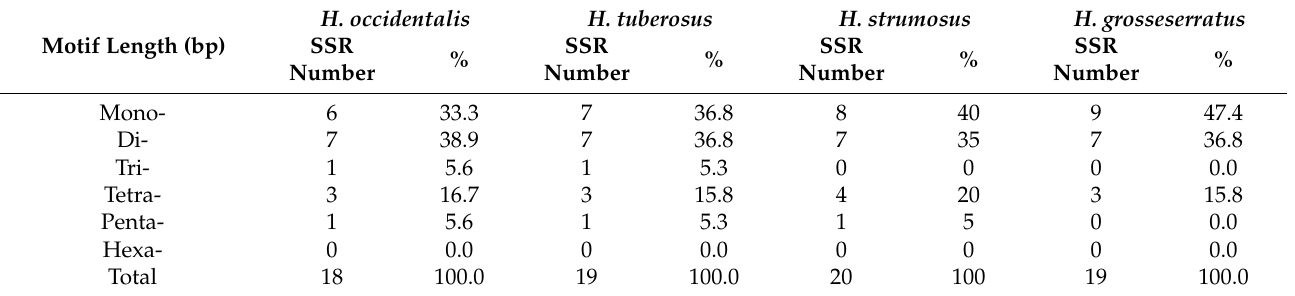
Table 1. SSR motif